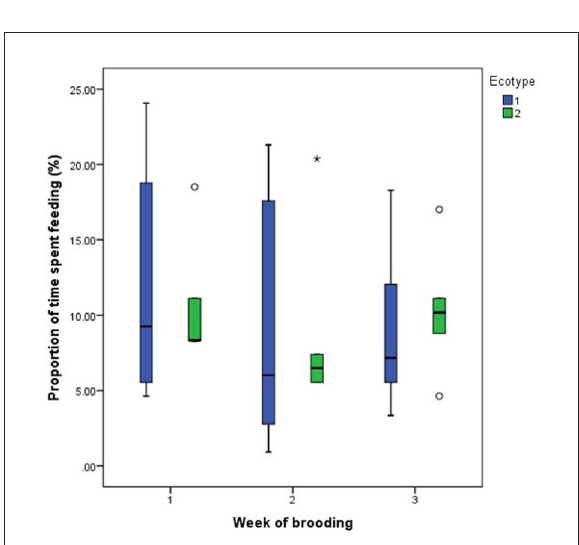
FIGURE5 Proportion of time spent by two Nigerian indigenous hen ecotypes (1 = Yoruba and 2 = Fulani) feeding over the three weeks of brooding. Outliers in the data are depicted by the symbol “* or ◦